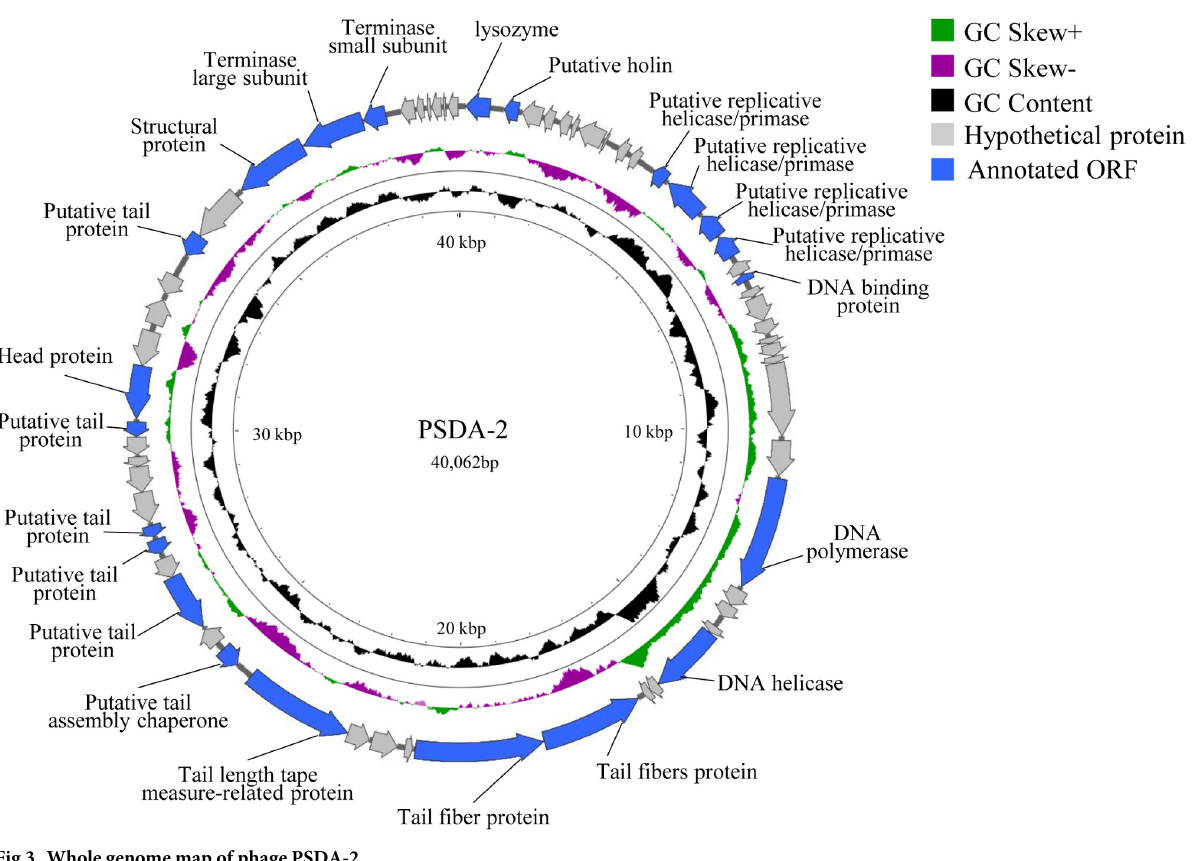
Fig 3. Whole genome map of phage PSDA-2.